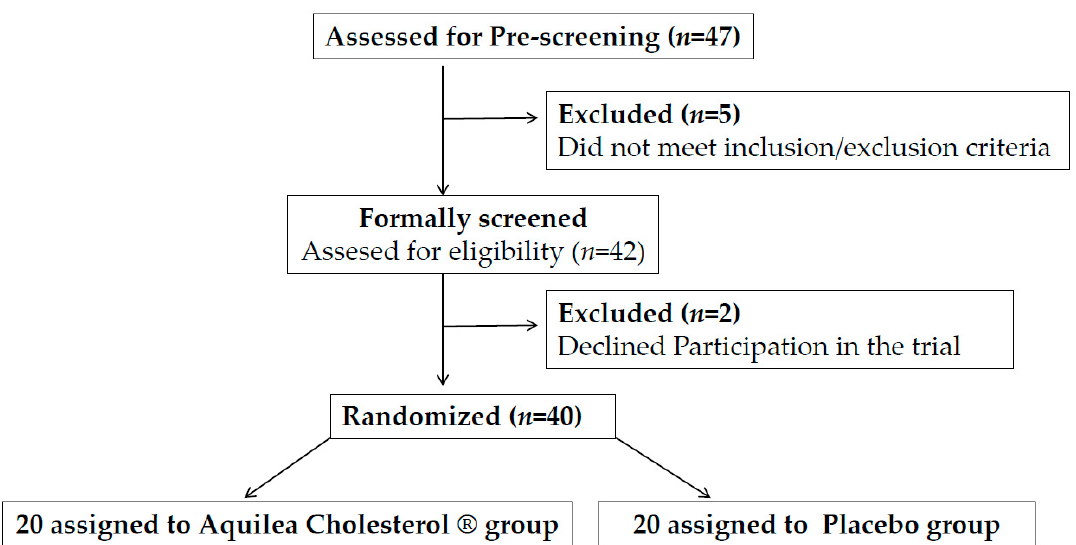
Figure 1. Flowchart of participants.